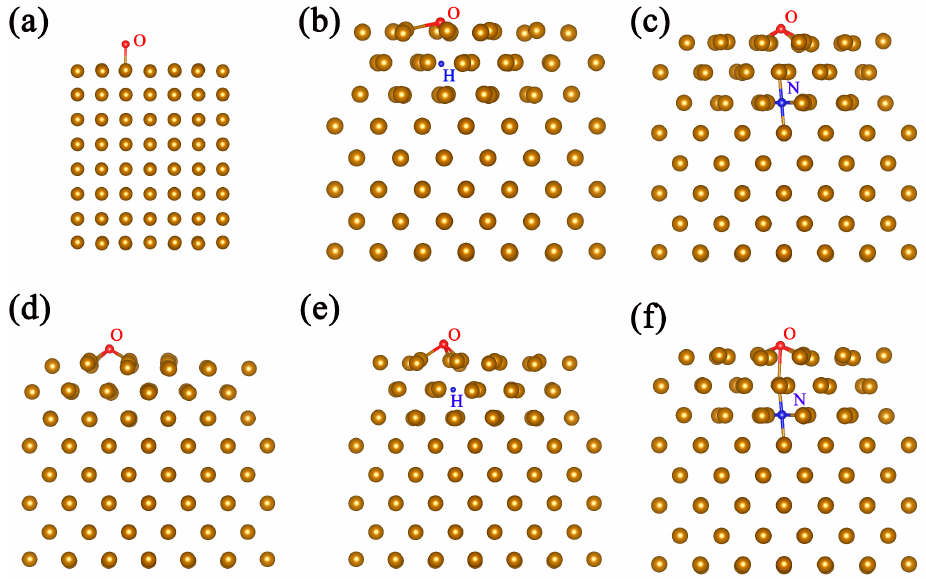
Figure 4. Model for the adsorption of atomic oxygen on pure γ -Fe and H/N-containing austenite. ( a – c ) are the models for the adsorption of atomic oxygen on pure γ -Fe and H/N-containing austenite before geometry optimization, respectively. ( d – f ) are the models for the adsorption of atomic oxygen on pure γ -Fe and H/N-containing austenite after geometry optimization, respectively. Table 2. Adsorption energy, cohesive energy and Mulliken charge of atomic oxygen of all models. E ads